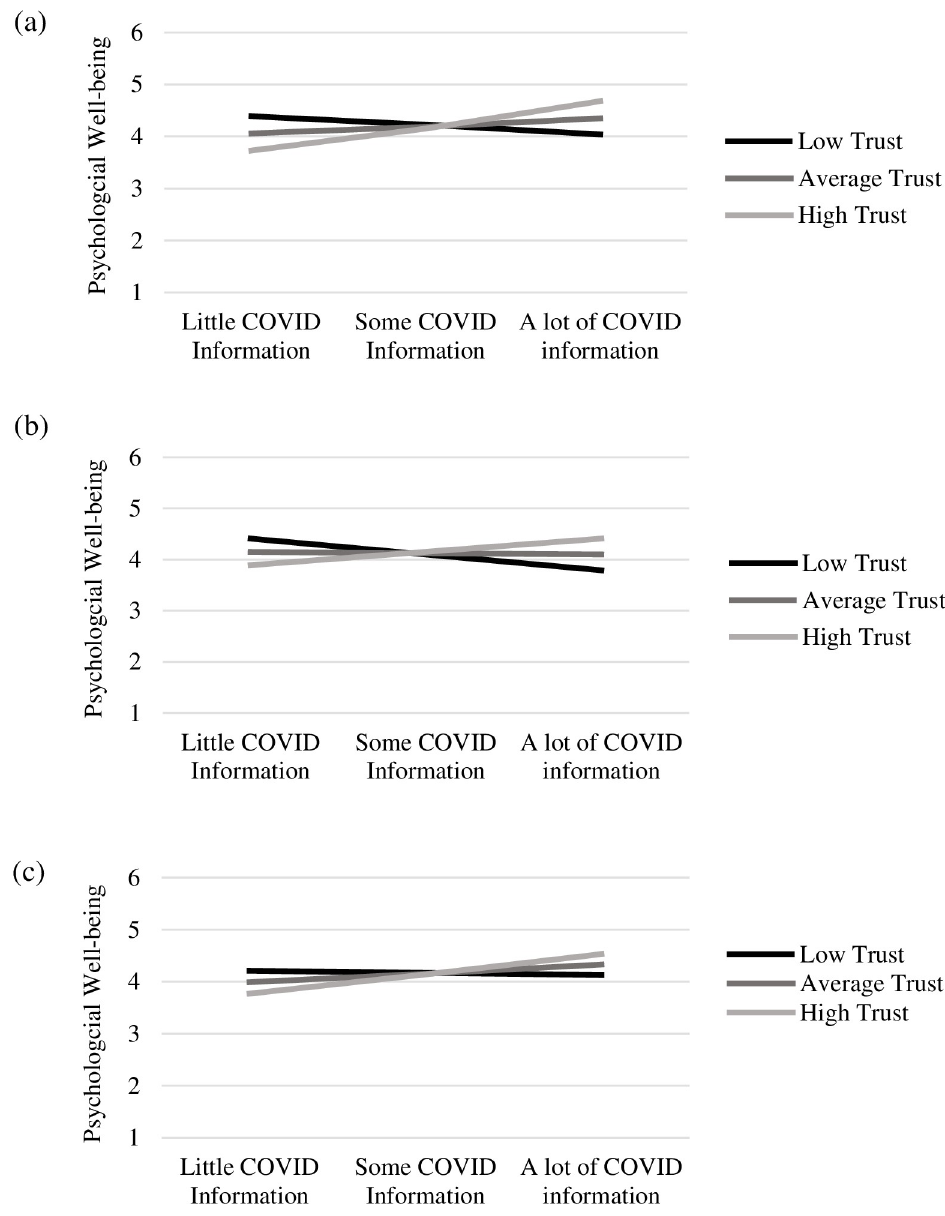
Fig 1. Moderation Effect of Trust of COVID-19 Information on the Relation between Frequency of COVID-19 Information on (a) Facebook, (b) TikTok, and (c) Twitter with Psychological Well-being. Note . Solid lines indicate a significant effect and dashed lines indicate a non-significant